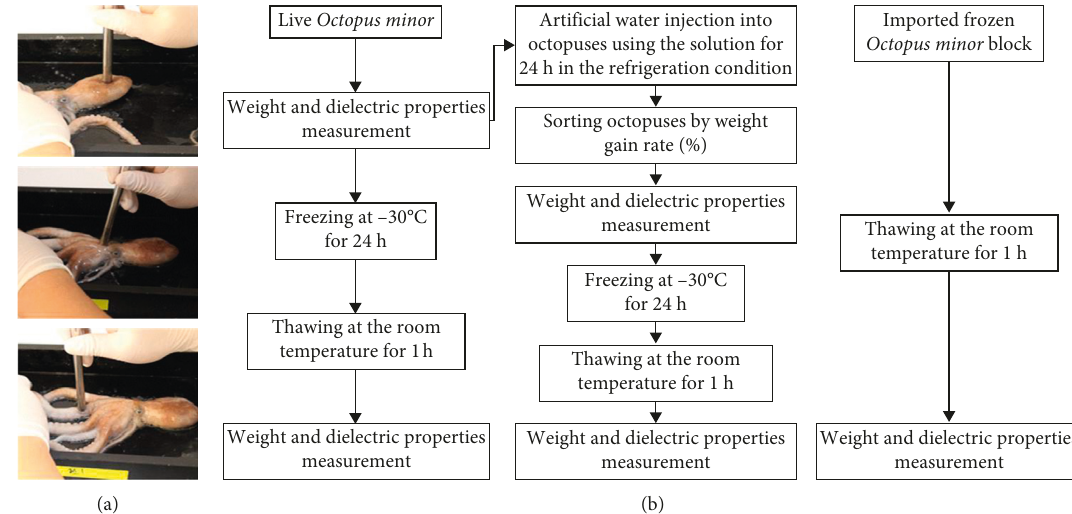
Figure 1: Dielectric properties measurement: (a) measuring location; (b) experimental protocol.